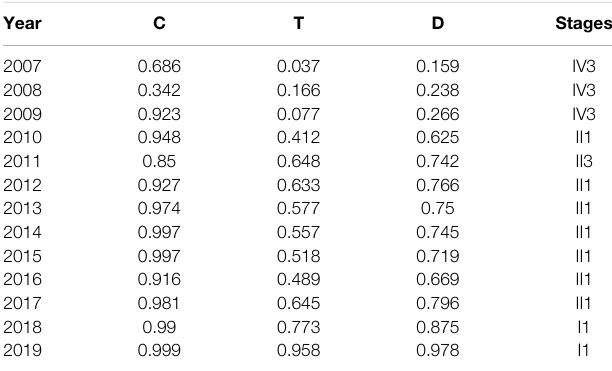
TABLE 3 | Coupling coordination of economic-social and natural ecological niches (2007 –